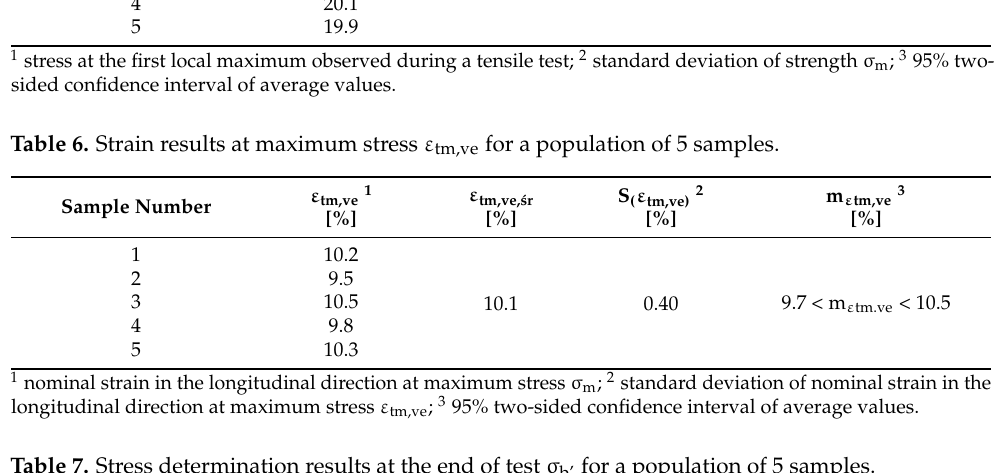
Table 7. Stress determination results at the end of test σ b’ for a population of 5 samples.